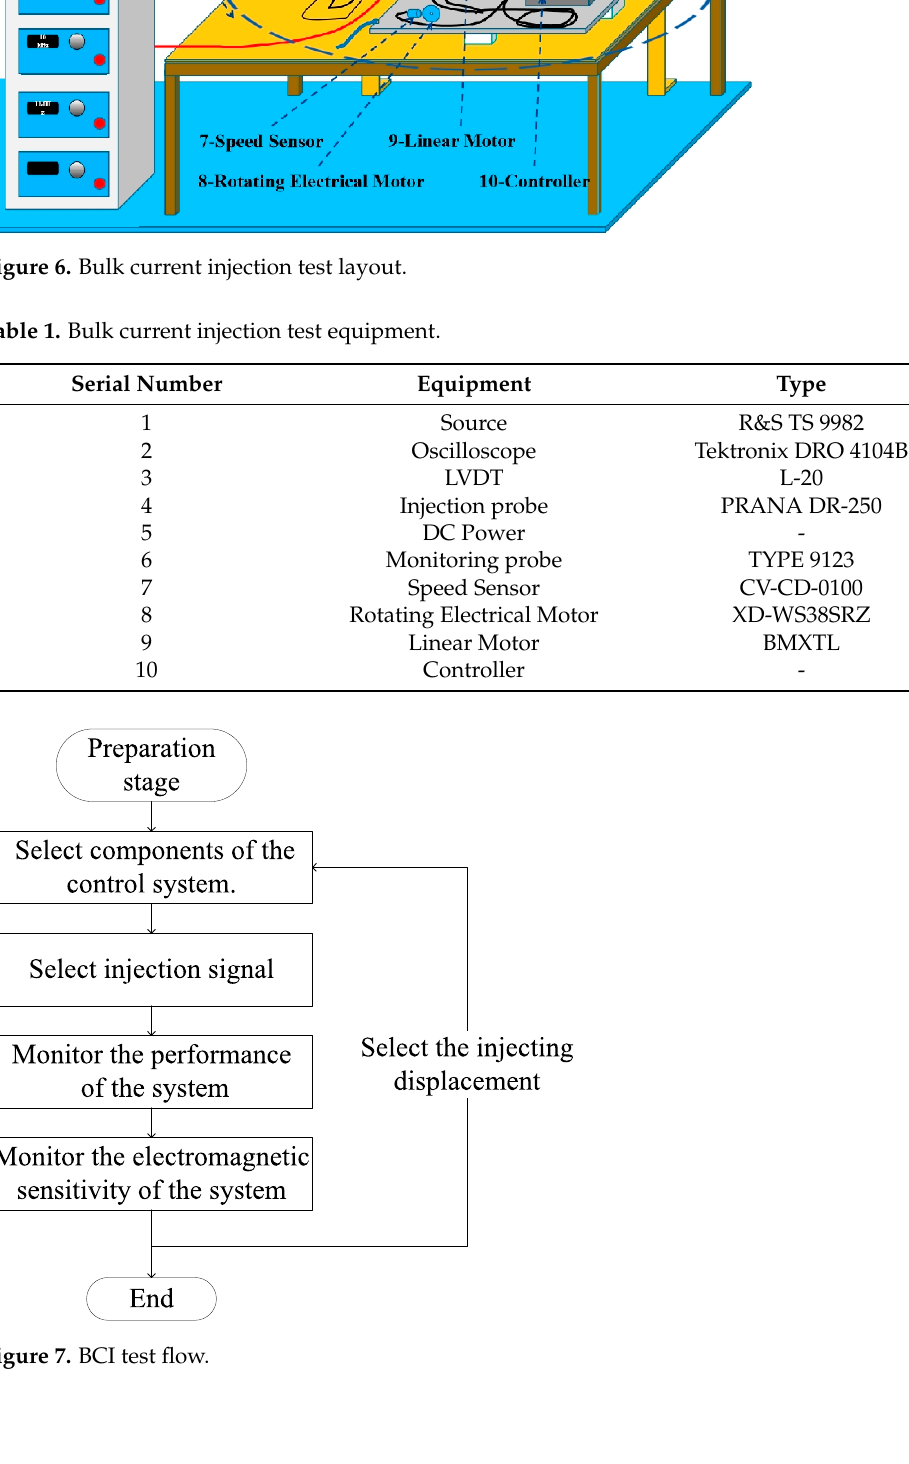
Figure 7. BCI test flow.